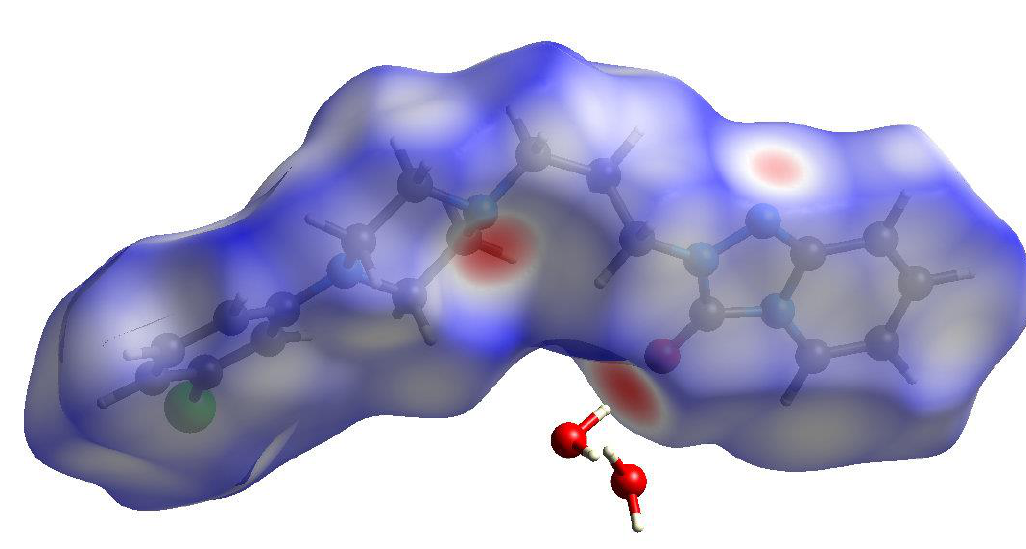
Molecules 2021 , 26 , x 9 of 12 Figure 9. The Hirshfeld surface for β -C 19 H 22 ClN 5 O · 2H 2 O mapped over d norm ( − 0.67 to 1.25 arbitrary units). Figure 9. The Hirshfeld surface for β -C 19 H 22 ClN 5 O·2H 2 O mapped over d norm ( – 0.67 to 1.25 arbitrary units). The Hirshfeld surface for the C1 molecule in γ -C 19 H 22 ClN 5 O·2H 2 O (Figure 10) shows broadly similar features, with intense red spots near O1 and N4 corresponding to the strong hydrogen bonds accepted by these atoms. A faint red spot near Cl1 is somewhat more prominent than the equivalent feature for the Cl atom in the β polymorph. The sur- face for the C20 molecule (not shown), is very similar in appearance, which is to be ex- pected given the pseudo-symmetry in the structure noted above.